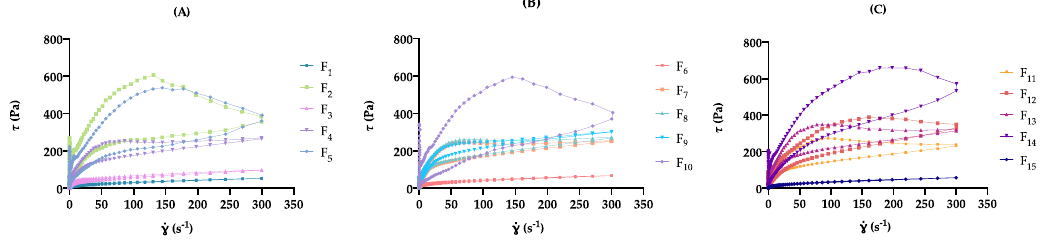
Figure 3. E ff ect of independent variables on cream thixotropic behavior: ( A ) F 1 –F 5 , ( B ), F 6 –F 10 and Figure 3. Effect of independent variables on cream thixotropic behavior: (A) F 1 –F 5 , (B), F 6 –F 10 and (C) ( C ) F 11 –F 15 F 11 –F 15 .